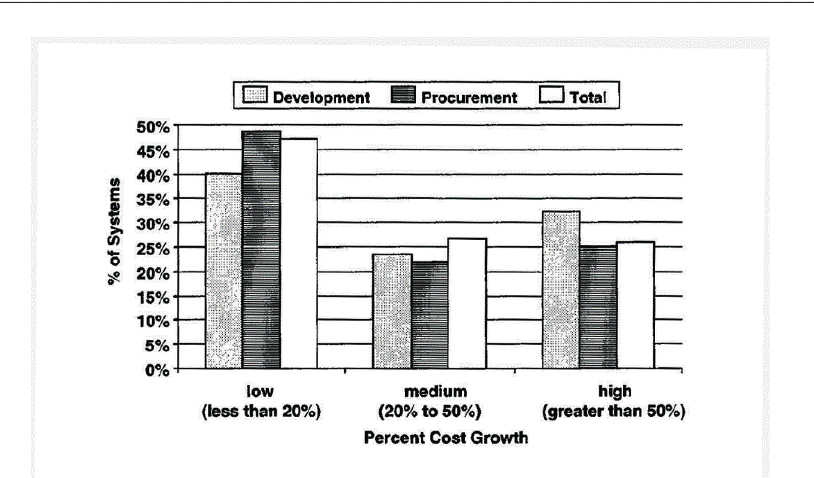
Fig. 18. Programs experiencing cost growth (Logistics Management Institute, 2000: